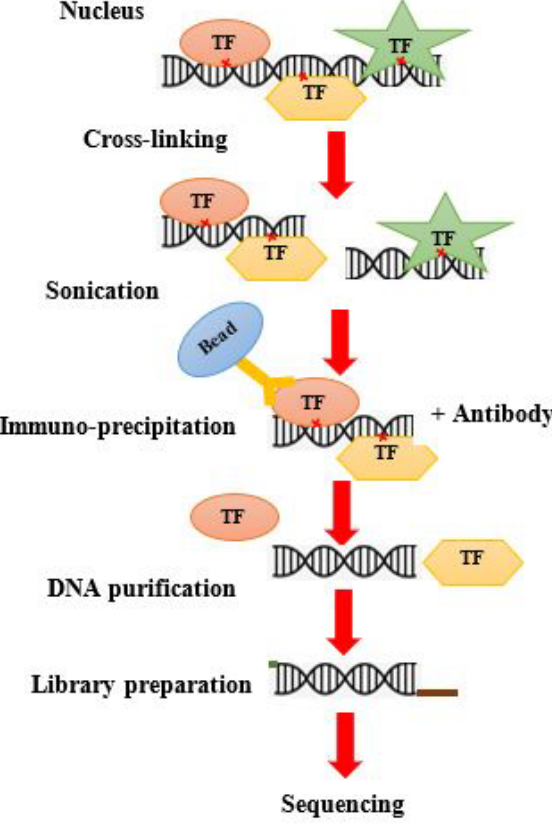
Figure 4. Workflow of ChIP seq.